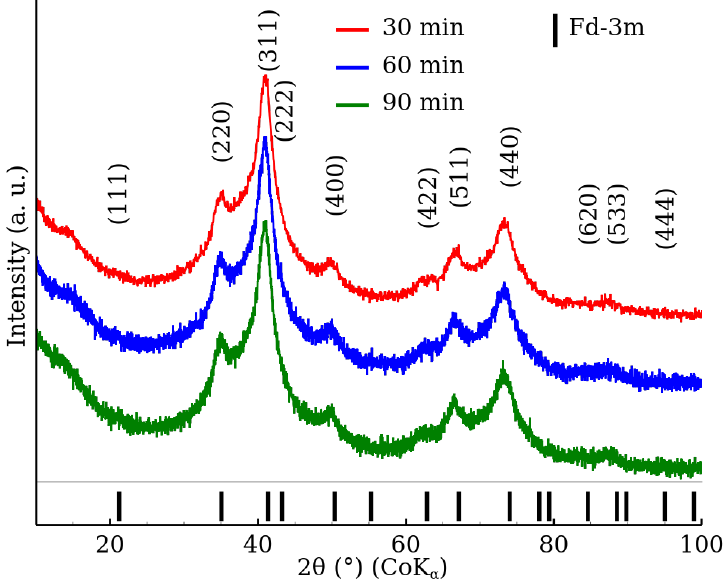
Figure 1. XRD patterns of zinc ferrite nanoparticles prepared with the microwave field turned off (samples RT-30, RT-60 and RT-90) in the 2 θ range from 10° to 100°. The data were normalized with respect to the measurement time per